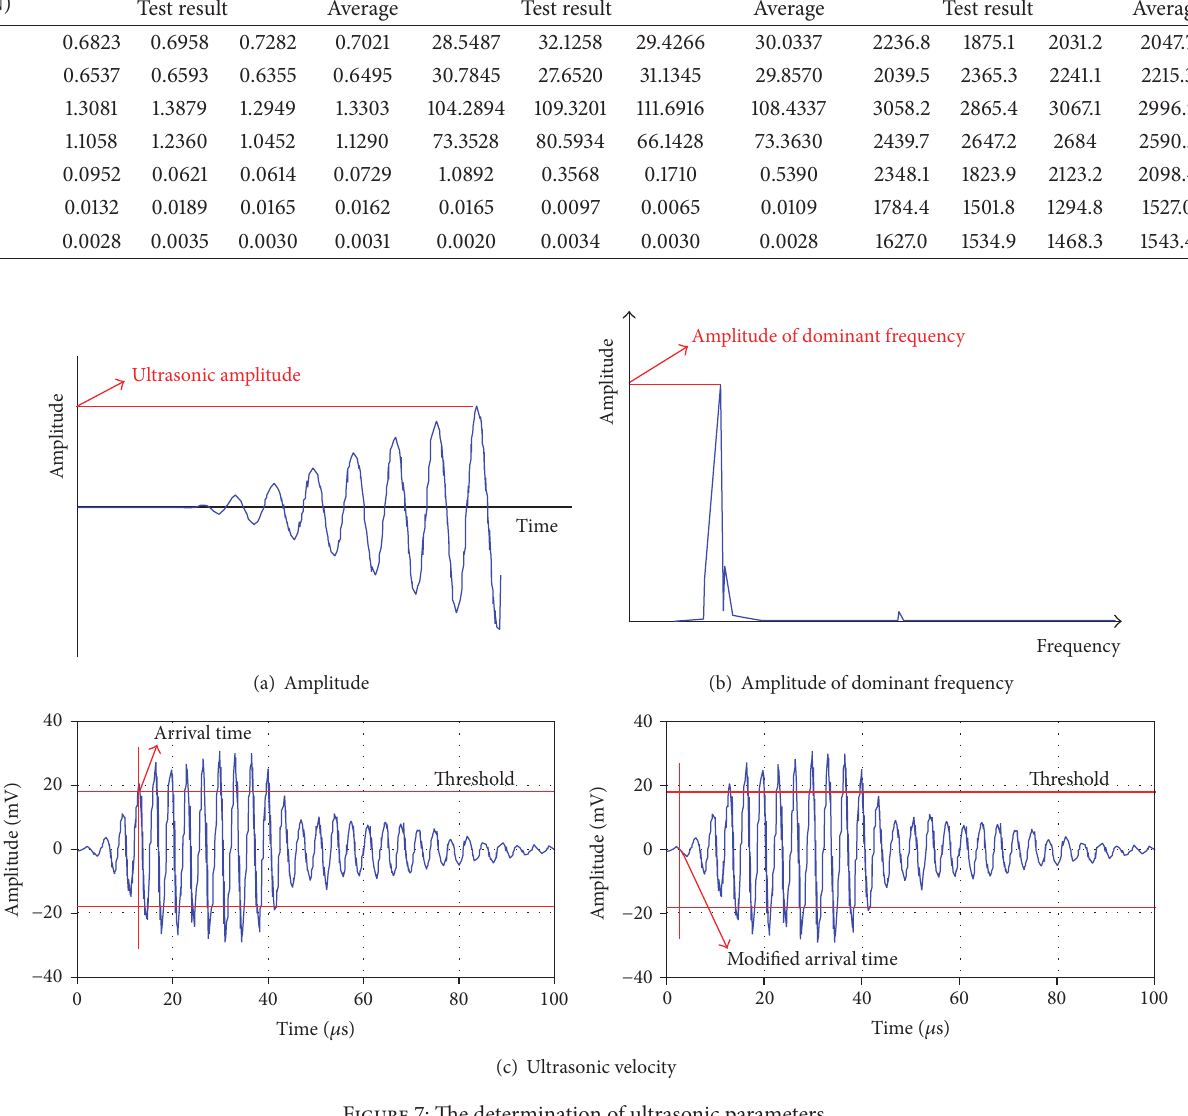
Figure 7: The determination of ultrasonic